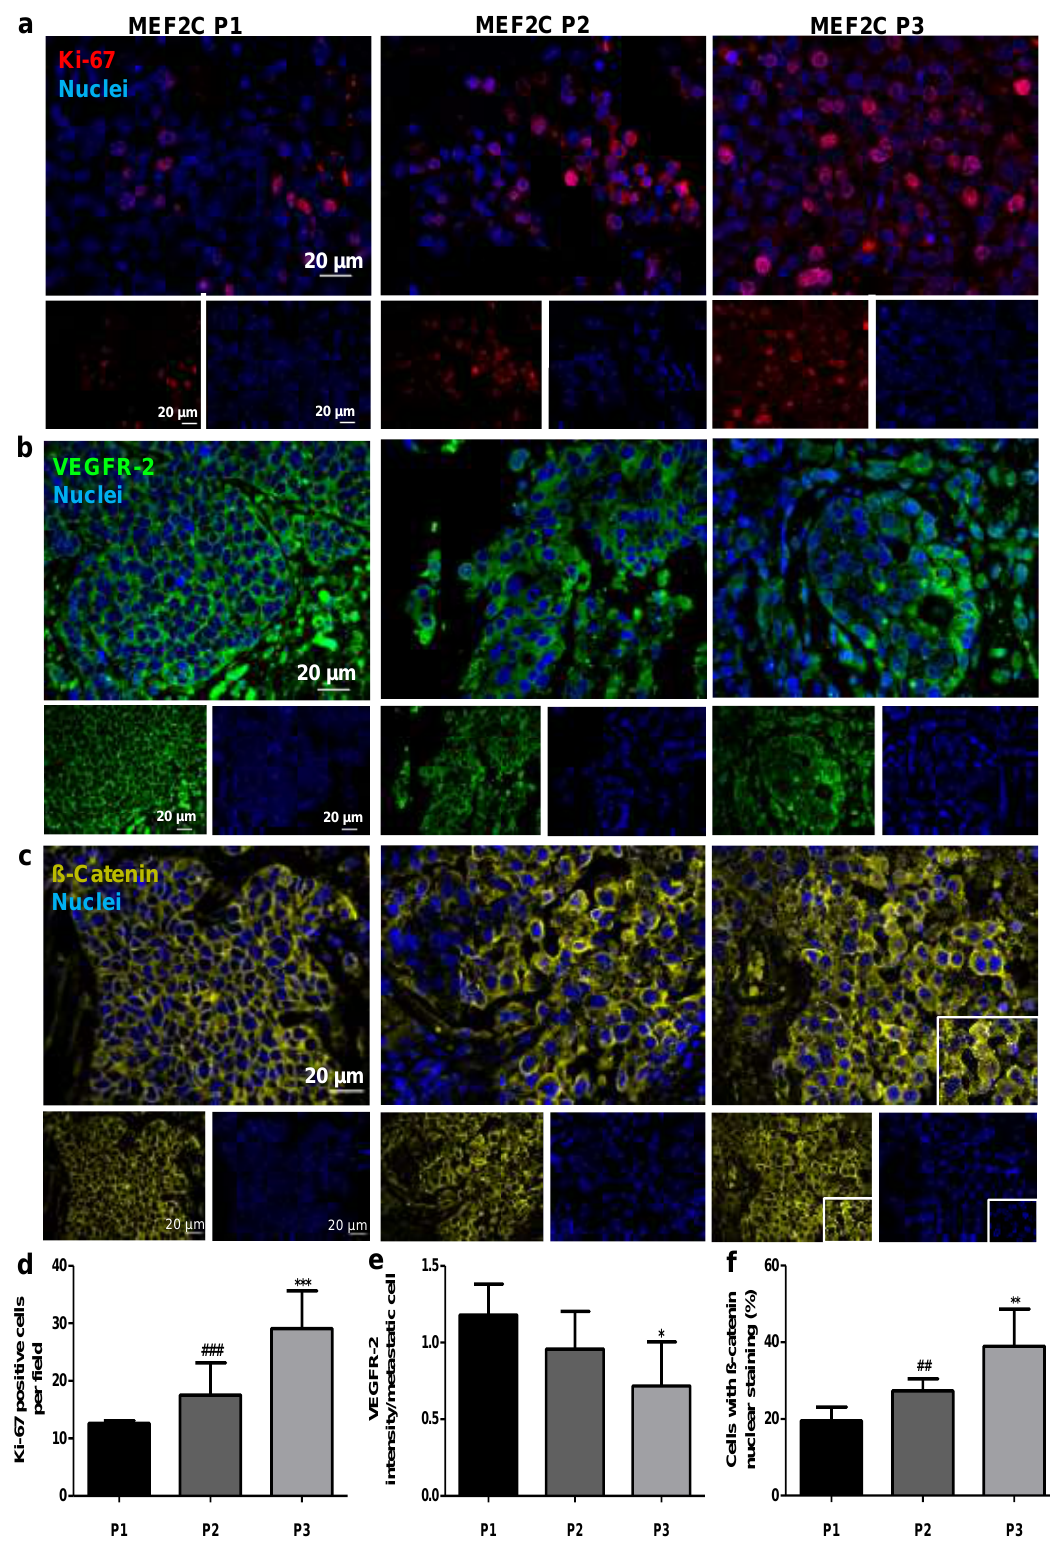
Figure 3. Ki-67, vascular endothelial growth factor receptor 2 (kinase domain insert domain receptor, KDR) and ß-catenin (CTNNB1) expression in resected human breast cancer brain metastases. Immunofluorescence analysis was performed in tissue sections from breast cancer brain metastases. Analysis of the proliferation marker, Ki-67 (red), revealed an increasing presence of Ki-67 positive cells in breast cancer brain metastases as a function of the myocyte enhancer factor 2C (MEF2C) expression phenotype (P1, P2 and P3) ( a ). Analysis of vascular endothelial growth factor receptor 2 (VEGFR-2;